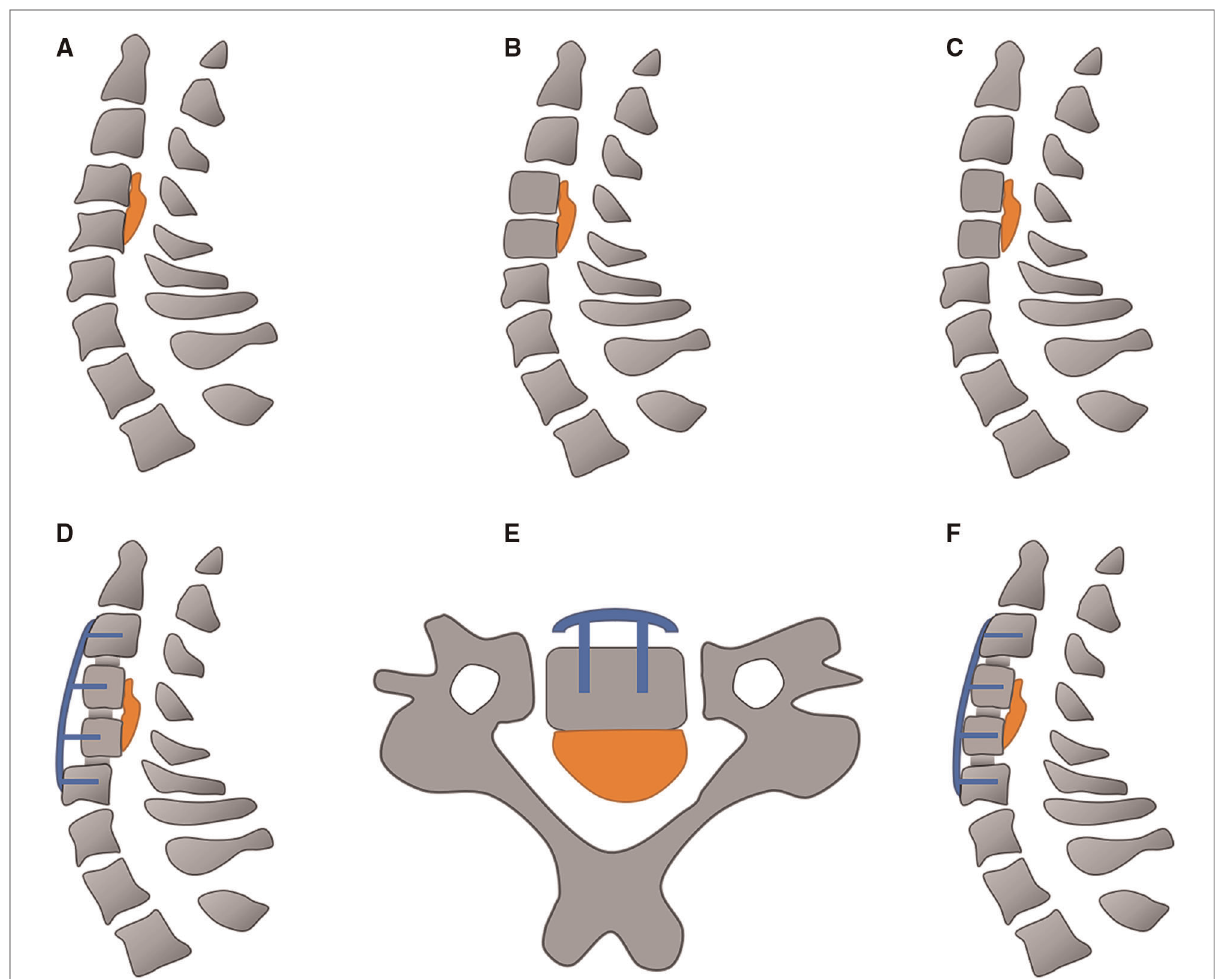
FIGURE 3 Schematic diagram of anterior controllable antedisplacement and fusion surgery. ( A ) The ossi fi cation of posterior longitudinal ligament at C4 – C5; ( B ) conventional discectomy is performed in the involved levels; ( C ) resection of the anterior vertebral bodies of C4 – C5; ( D ) installation of intervertebral cages, screws, and pre-bent anterior cervical plate; ( E ) creation of bilateral groove; ( F ) hoisting C4 – C5